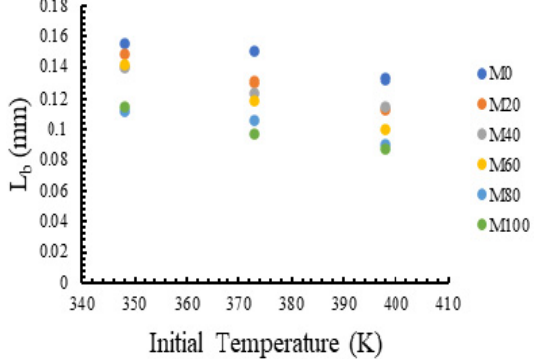
Figure 12: Markstein length versus initial temperature at different methanol blends. The un-stretched laminar flame speed (S ) is calcu– l lated as the intercept point of S at α =0 in the plot of S n n versus α . The strain in the flow field causes a severe dec– rease of S in small stretch rate, and the cellular flame n causes a severe increase of S in small stretch rate [21]. For n reasons mentioned above the unstreched flame seed is obtained for the flame in the second stage of propagation which is at radius from 8-40 mm in the calculations.